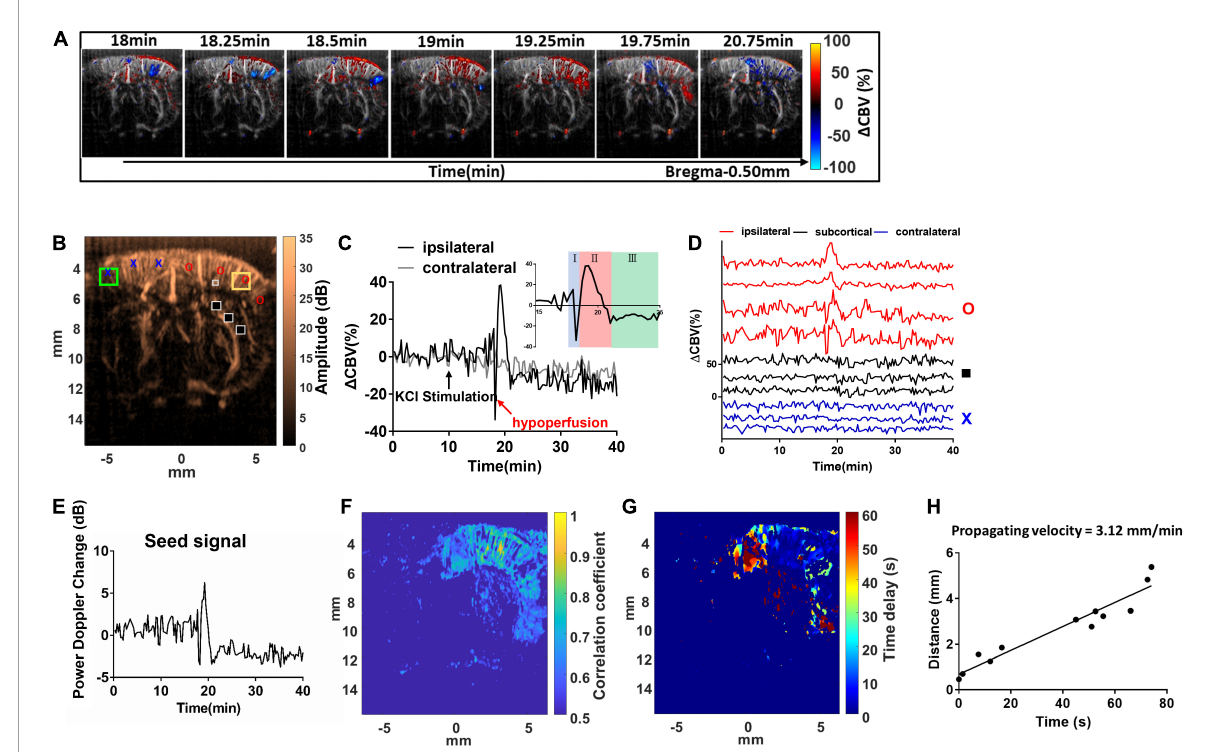
FIGURE3 Dynamic ultrafast Doppler images of CBV during a representative episode of CSD. (A) Spatiotemporal evolution of CBV changes in rat cerebral cortex in response to CSD acquired by sequence of power Doppler imaging. The color bar was indexed as (cid:49) CBV(%) from –100 to 100%. Positive values representing increase in CBV are coded as red, while negative values representing decrease in CBV are coded as blue. (B) The power Doppler image showing the selected ROIs (1 mm × 1 mm) for the wide range analysis in ipsilateral (yellow square) and contralateral cortex (green square), and the ROIs for single-pixel analysis located in ipsilateral (red circle), subcortical (black square), and contralateral (blue cross) regions, and the seed ROI (gray box) for seed-based correlation map. (C) Temporal profiles of 1CBV during CSD in the hemisphere ipsilateral (black) and contralateral (gray) to the KCl application site. The black arrow indicates the stimulation of KCl. (D) Temporal profile of (cid:49) CBV during CSD from the representative pixels in the ipsilateral cortex to the KCl application site (red), subcortical region (black), and contralateral cortex (blue). (E) The representative temporal profile of vascular response extracted from the seed ROI. (F) The seed-based correlation map was obtained by subsequently correlating with the temporal profile at each pixel in the whole brain with the seed signal. (G) The propagation time delay map was obtained by the phase difference of power Doppler signals between seed point and other regions, and (H) the distance–time plot was used to measure the propagating velocity. The slope of the linear regression curve can be measured as the propagating velocity of spreading